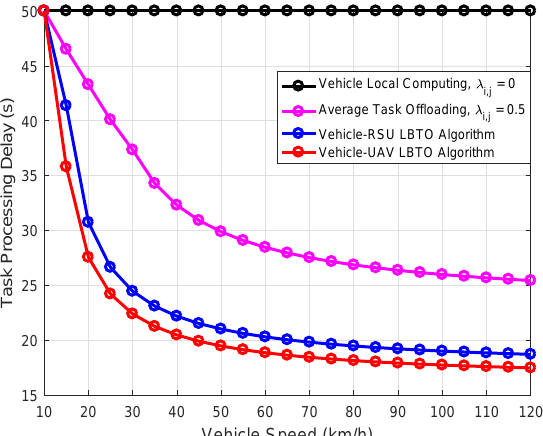
Figure 7. Comparison of the task processing delay with respect to the vehicle speed under differ- ent algorithms.